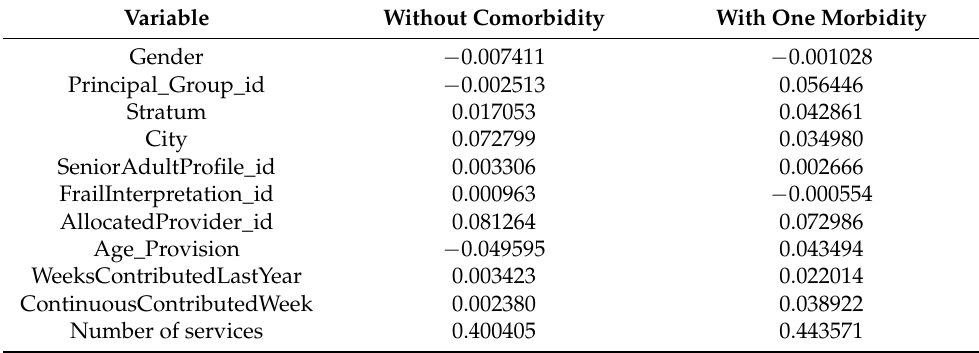
Table 3. Correlation of variables with or without morbidity with the